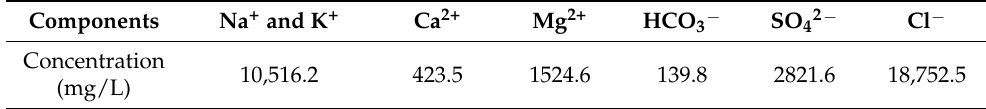
Table 1. Composition of Y oil-field formation water.